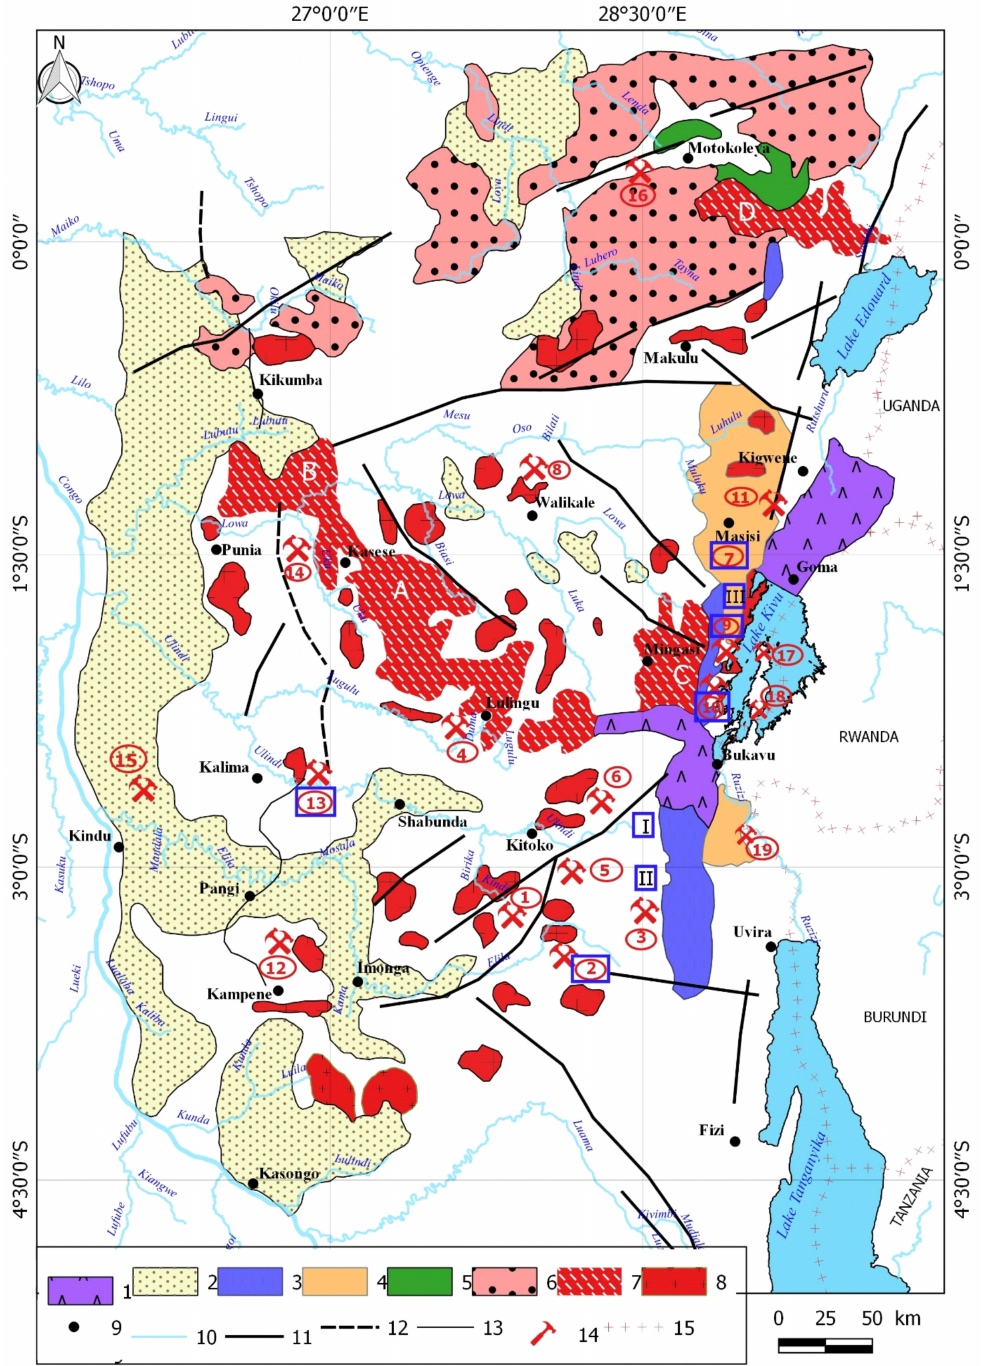
Figure 4. The main granitic outcrops and mineral districts in the Kivu Belt (KVB). Legend: 1—tertiary volcanism, 2—Karoo and post-Karoo formations, 3—Neoproterozoic formations, 4—K4 and K5 units, 5—Motokoleya Formation, 6—Kibalian (Paleoproterozoic basement), 7—granites of Kasese, Punia, Gondo Ya Bushema and Lubero (G1, G2 and G3 types), 8—granites of Kasika, Nzombe, Nyamakubi, Numbi, Kirumba, and Kobokobo (G4 type), 9—cities, 10—rivers, 11—main faults, 12—main faults supposed, 13—main roads, 14—main mining districts, 15—national borders. Circled numbers correspond to mineral districts cited in the text. Number in blue squares = geochronological samples, number in red circles included in blue squares = geochronological samples from mineral sites. Details are given in Table